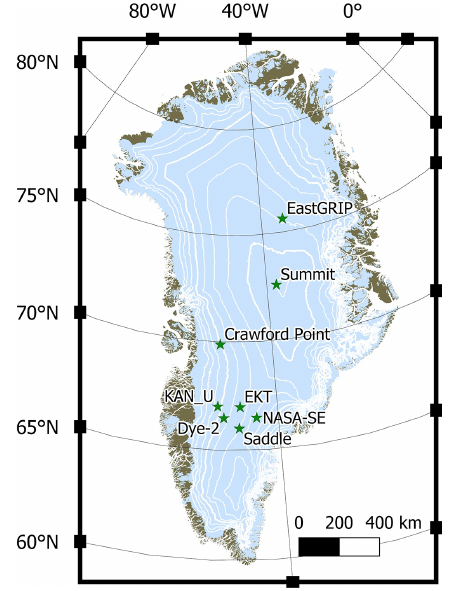
Figure 1. FirnCover station locations in Greenland. White lines are 1000m (thick) and 250m (thin) elevation contours from the GIMP digital elevation model (Howat et al.,